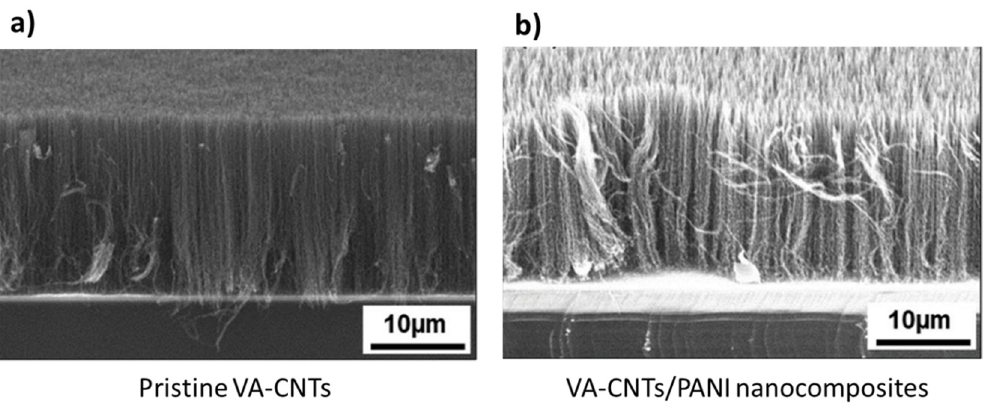
Figure 7. FESEM images of VA-CNTs ( a ) before and ( b ) after the grafting of polyaniline by a grafting- method (Reprinted from Haq, A.U.; Lim, J.; Yun, J.M.; Lee, W.J.; Han, T.H.; Kim, S.O. Direct Growth of Polyaniline Chains from N-Doped Sites of Carbon Nanotubes. Small 2013 , 9 , 3829–3833 [23], with permission (2020) from